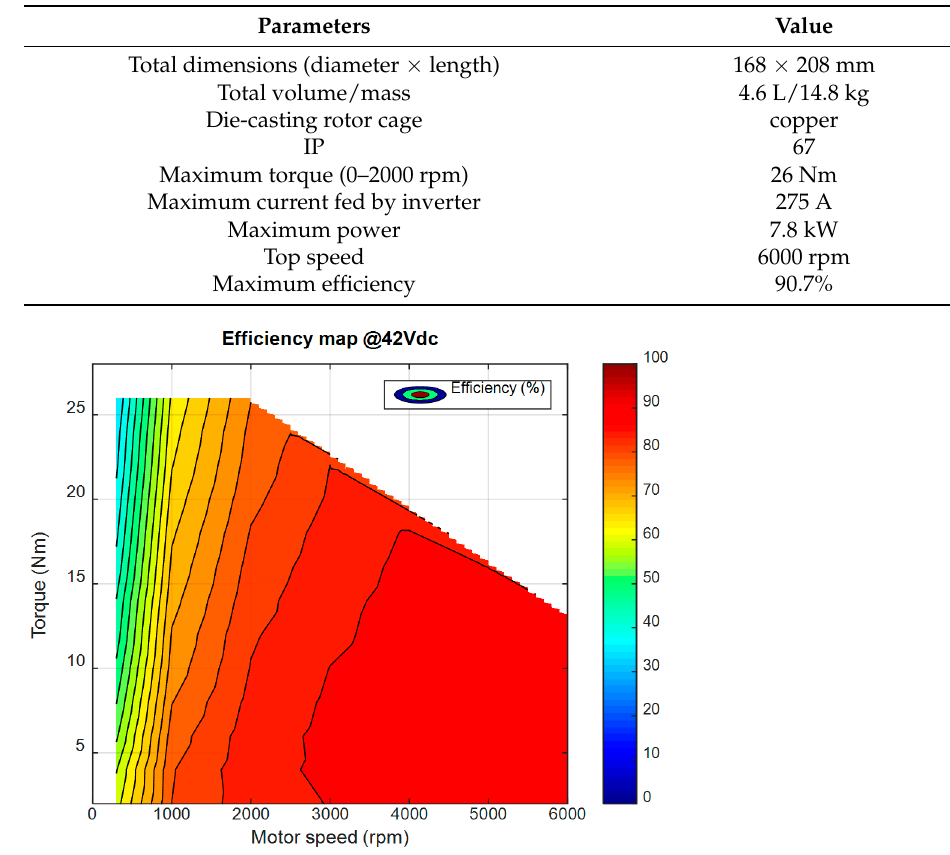
Table 1. E-engine design parameters and performances.